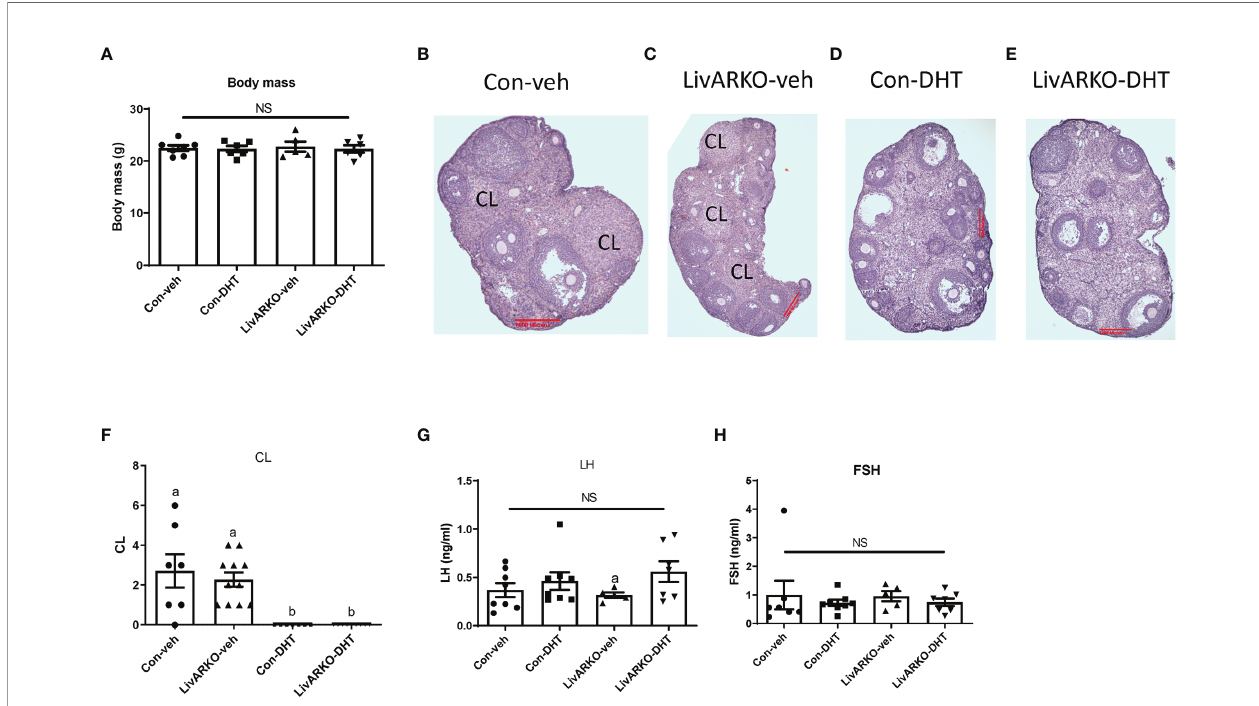
FIGURE 4 | Body mass, ovarian structure, and LH and FHS levels of mice with DHT treatment. (A) Body mass was recorded at 4 month old. Representative ovary structure for Con-veh (B) , LivARKO-veh (C) , Con-DHT (D) and LivARKO-DHT (E) . (F) Corpora lutea (CL) was counted every 10th section per ovary (n=7-11 per group). LH (G) and FSH (H) levels were measured at basal (Met/Destrus) stage. There was no difference in body mas, CL, basal LH and FSH levels among groups. (F) Statistical analysis was performed using two-way ANOVA followed by Tukey ’ s multiple tests. Bars with different letters represent signi fi cantly different values from each other with p<0.05. Values are mean ± SEM, n = 5-11/group. NS: non-signi fi